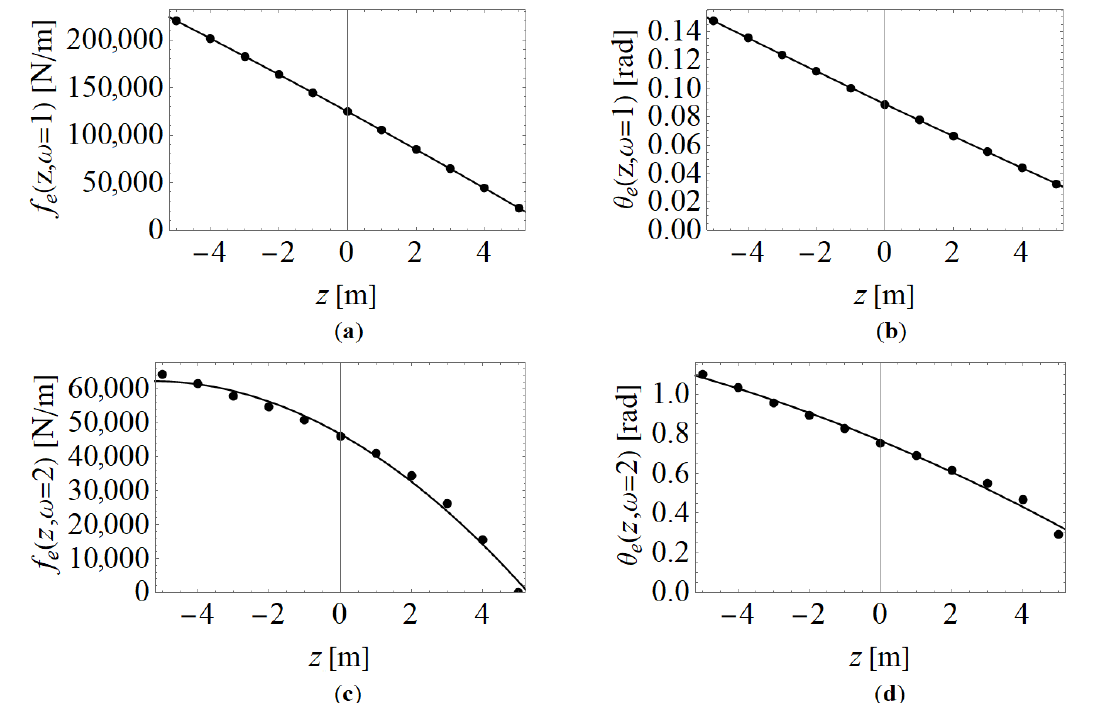
Figure 8. The excitation force ( a ) amplitude f e ( z , ω ) and ( b ) phase θ e ( z , ω ) as a function of the buoy position z for a wave frequency of ω = 1 [rad/s], and the excitation force ( c ) amplitude f e ( z , ω ) and ( d ) phase θ e ( z , ω ) as a function of the buoy position z for a wave frequency of ω = 2